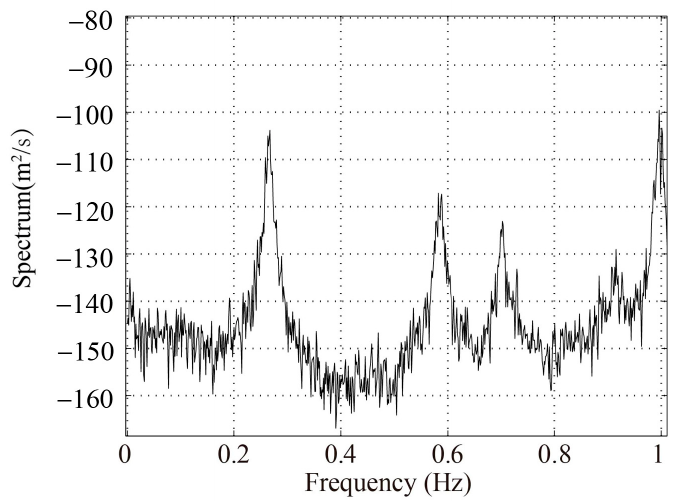
Figure 5. The power spectrum density function of Acc 1.